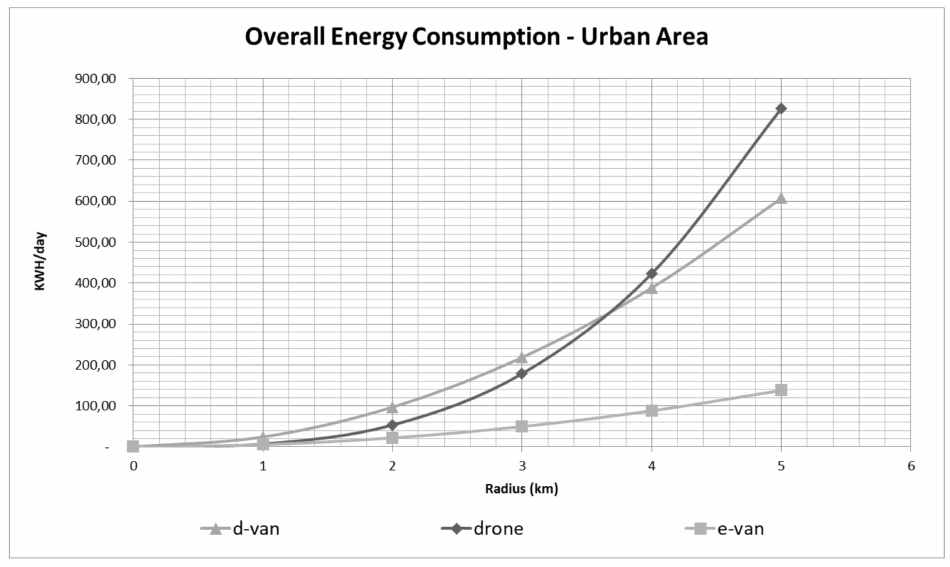
Figure 4. Energy consumption curves in Urban